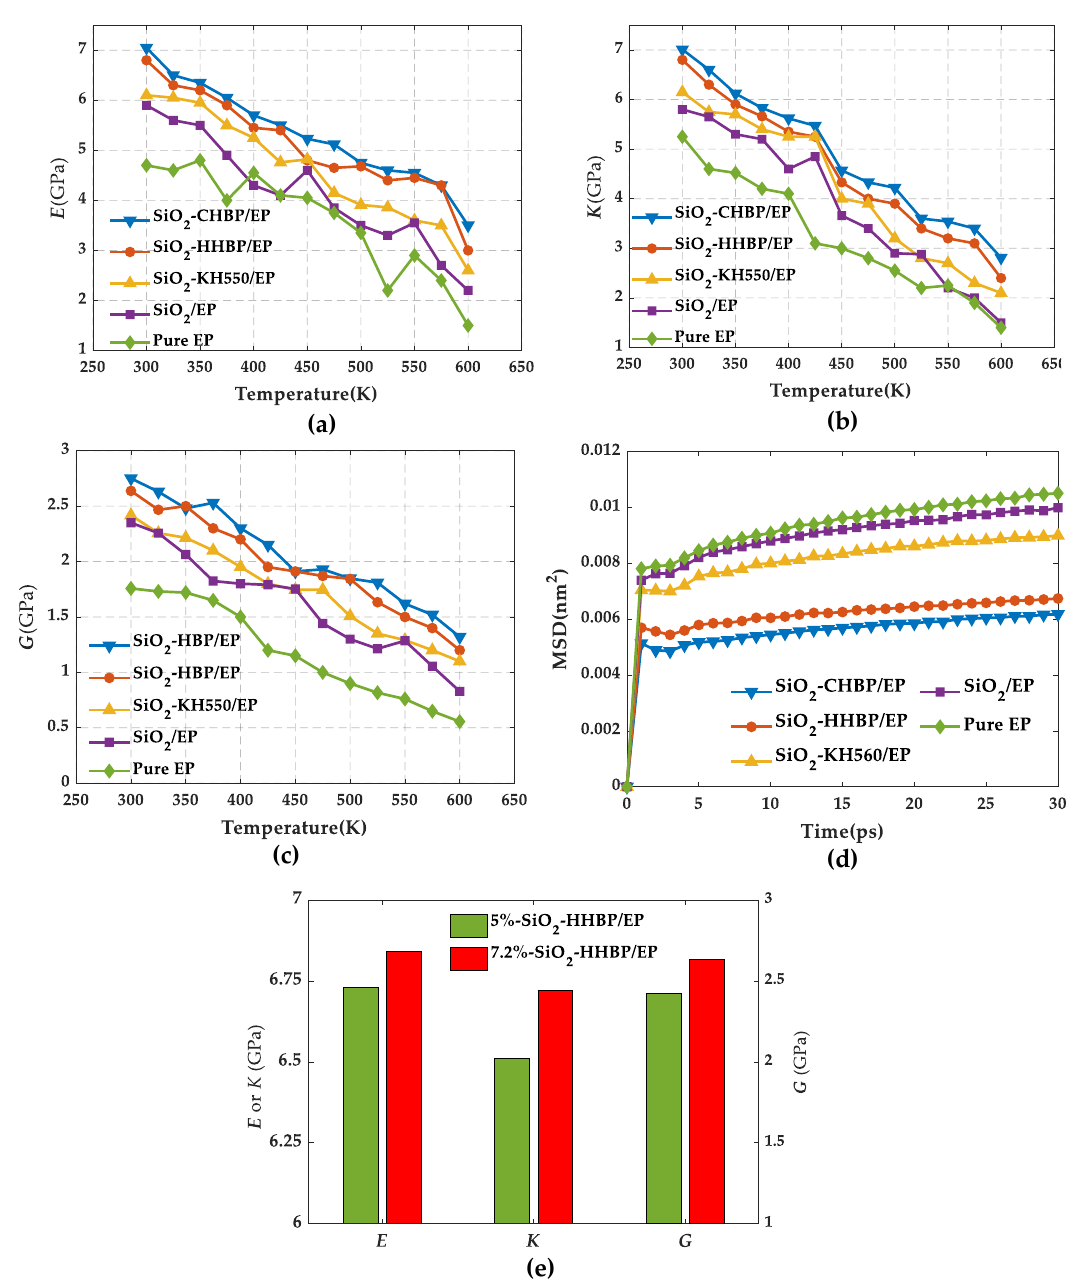
Table 4 reflects the fluctuation of the dipole moments and permittivity.